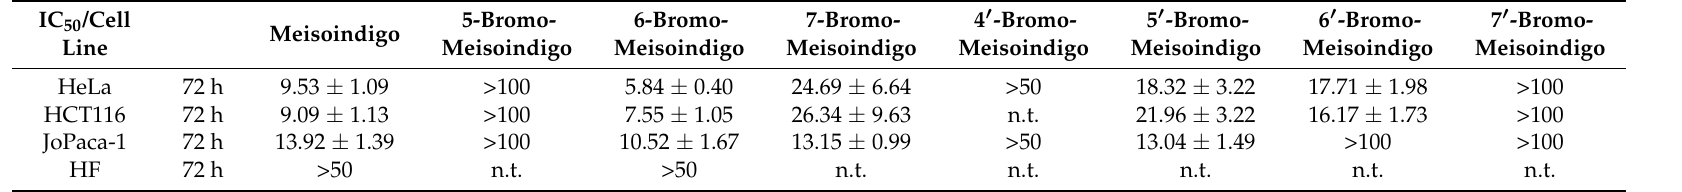
Table 2. IC50 values of compounds in HeLa, HCT116, and JoPaca-1 cells tested by MTT